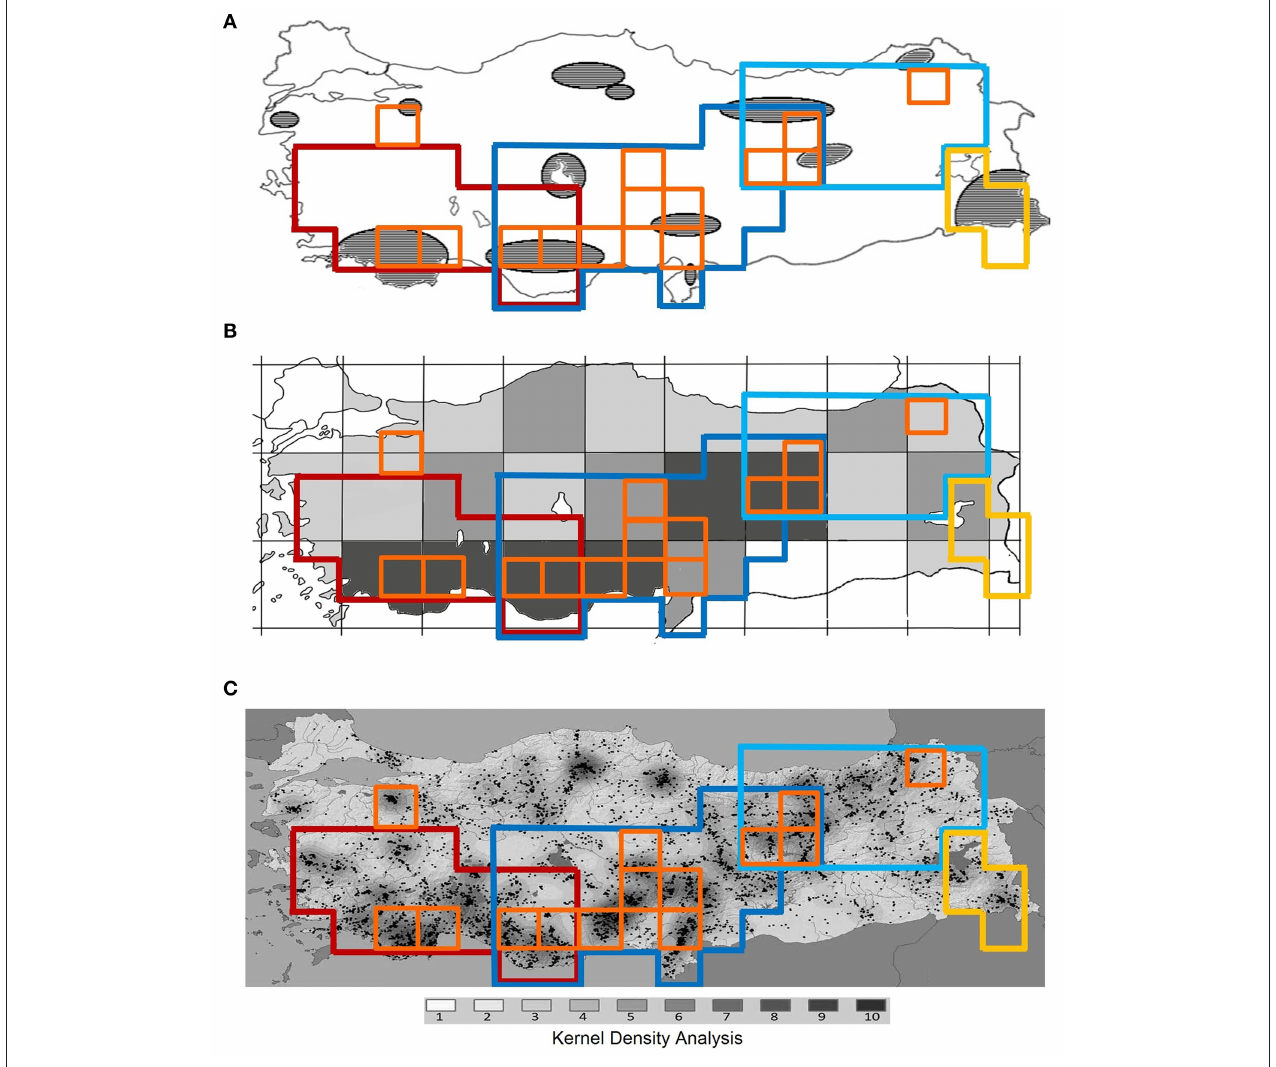
FIGURE 4 | Comparison of centers of endemism and areas of endemism identified in this study with centers of plant endemic diversity in Turkey identified previously by (A) Ekim et al. (2000), (B) Türe and Böcük (2010), (C) Senkul and Kaya